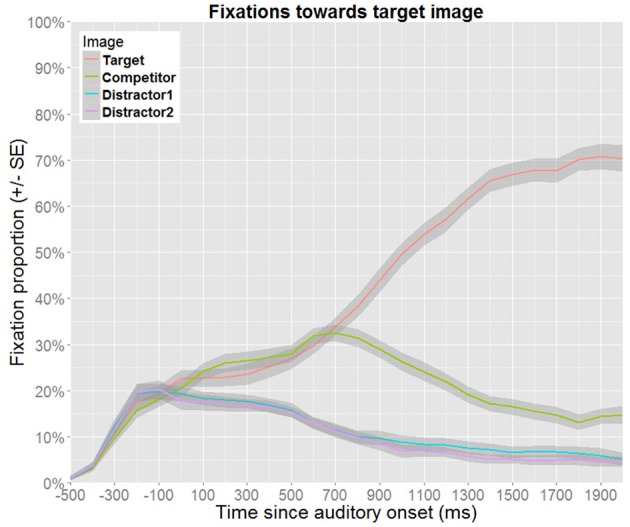
Proportion of fixations toward the target image as a function of time for target competitor trials. Proportions were calculated as subject means over 100 ms bins. Here, competition effects can be observed until disambiguating information from the suffix becomes available.